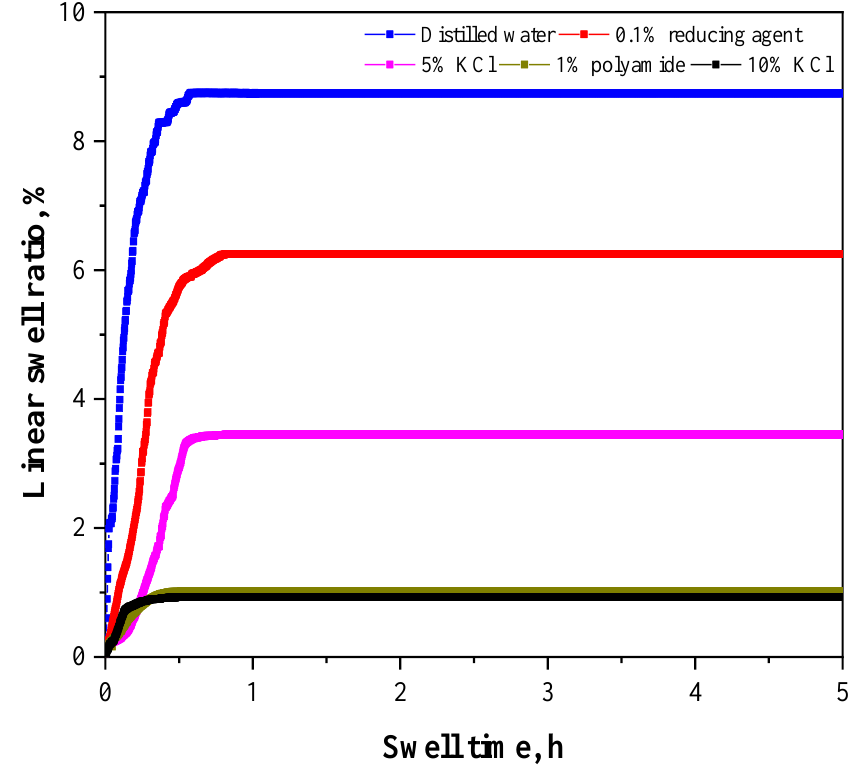
Figure 6. Linear expansion rate of the tight sandstone sample treated with different fluid.